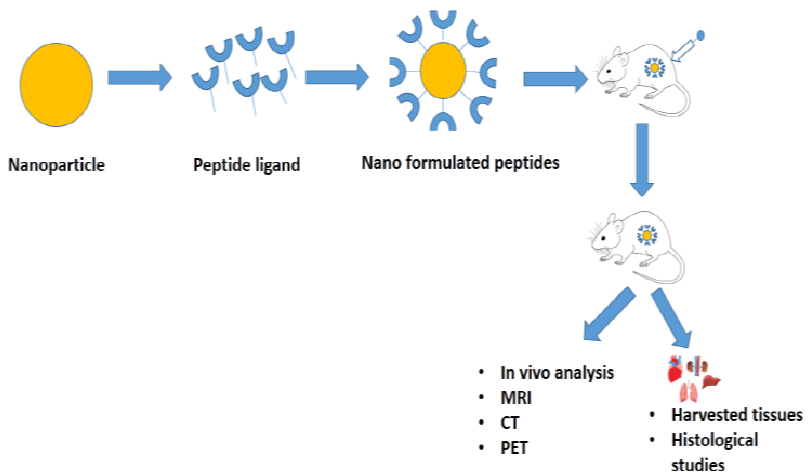
Figure 2. Types of in vivo analyses to evaluate the biological applications of nanoformulated peptides or peptide-conjugated/functionalized nanoparticles.